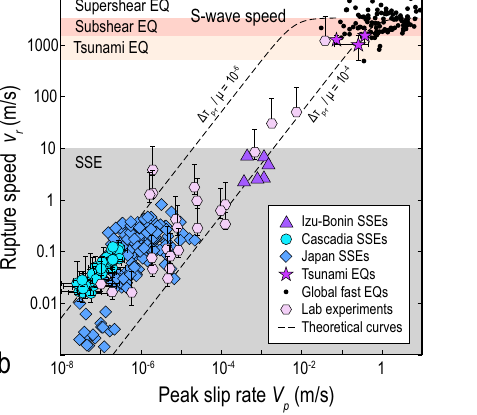
indicates uncertainty when available; Methods). Dashed curves are theoretical predictions (Methods). Δ τ p − r and μ are the peak-to-residual strength drop at the rupture front and shear modulus, respectively. c Models for energy ratio G c / G 0 integrating multiple frictional mechanisms. Purple curve represents one example of G c / G 0 for SSEs. Red dash and solid curves represent examples of G c / G 0 for earthquakes. Grey arrows indicate the evolution of rupture speed controlled by equation